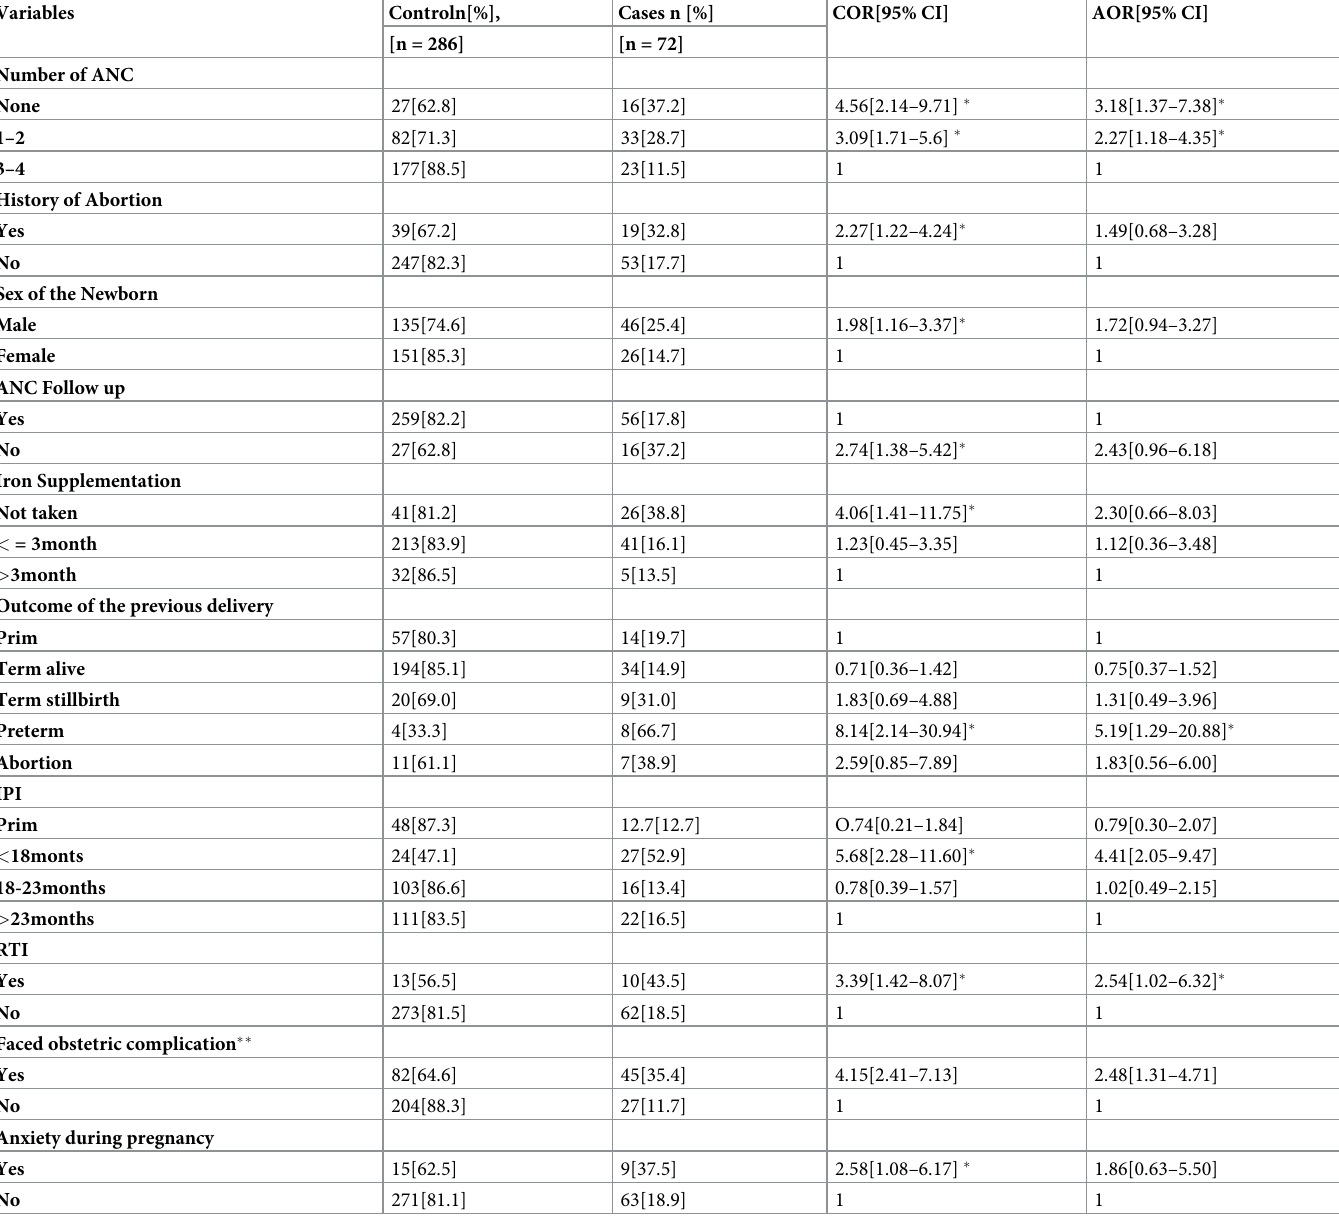
Table 2. Binary and multivariable logistic analysis of predictors of preterm birth cases (n = 72) and controls (n = 286) in selected hospitals of Wollega zones, 2017/ 18.